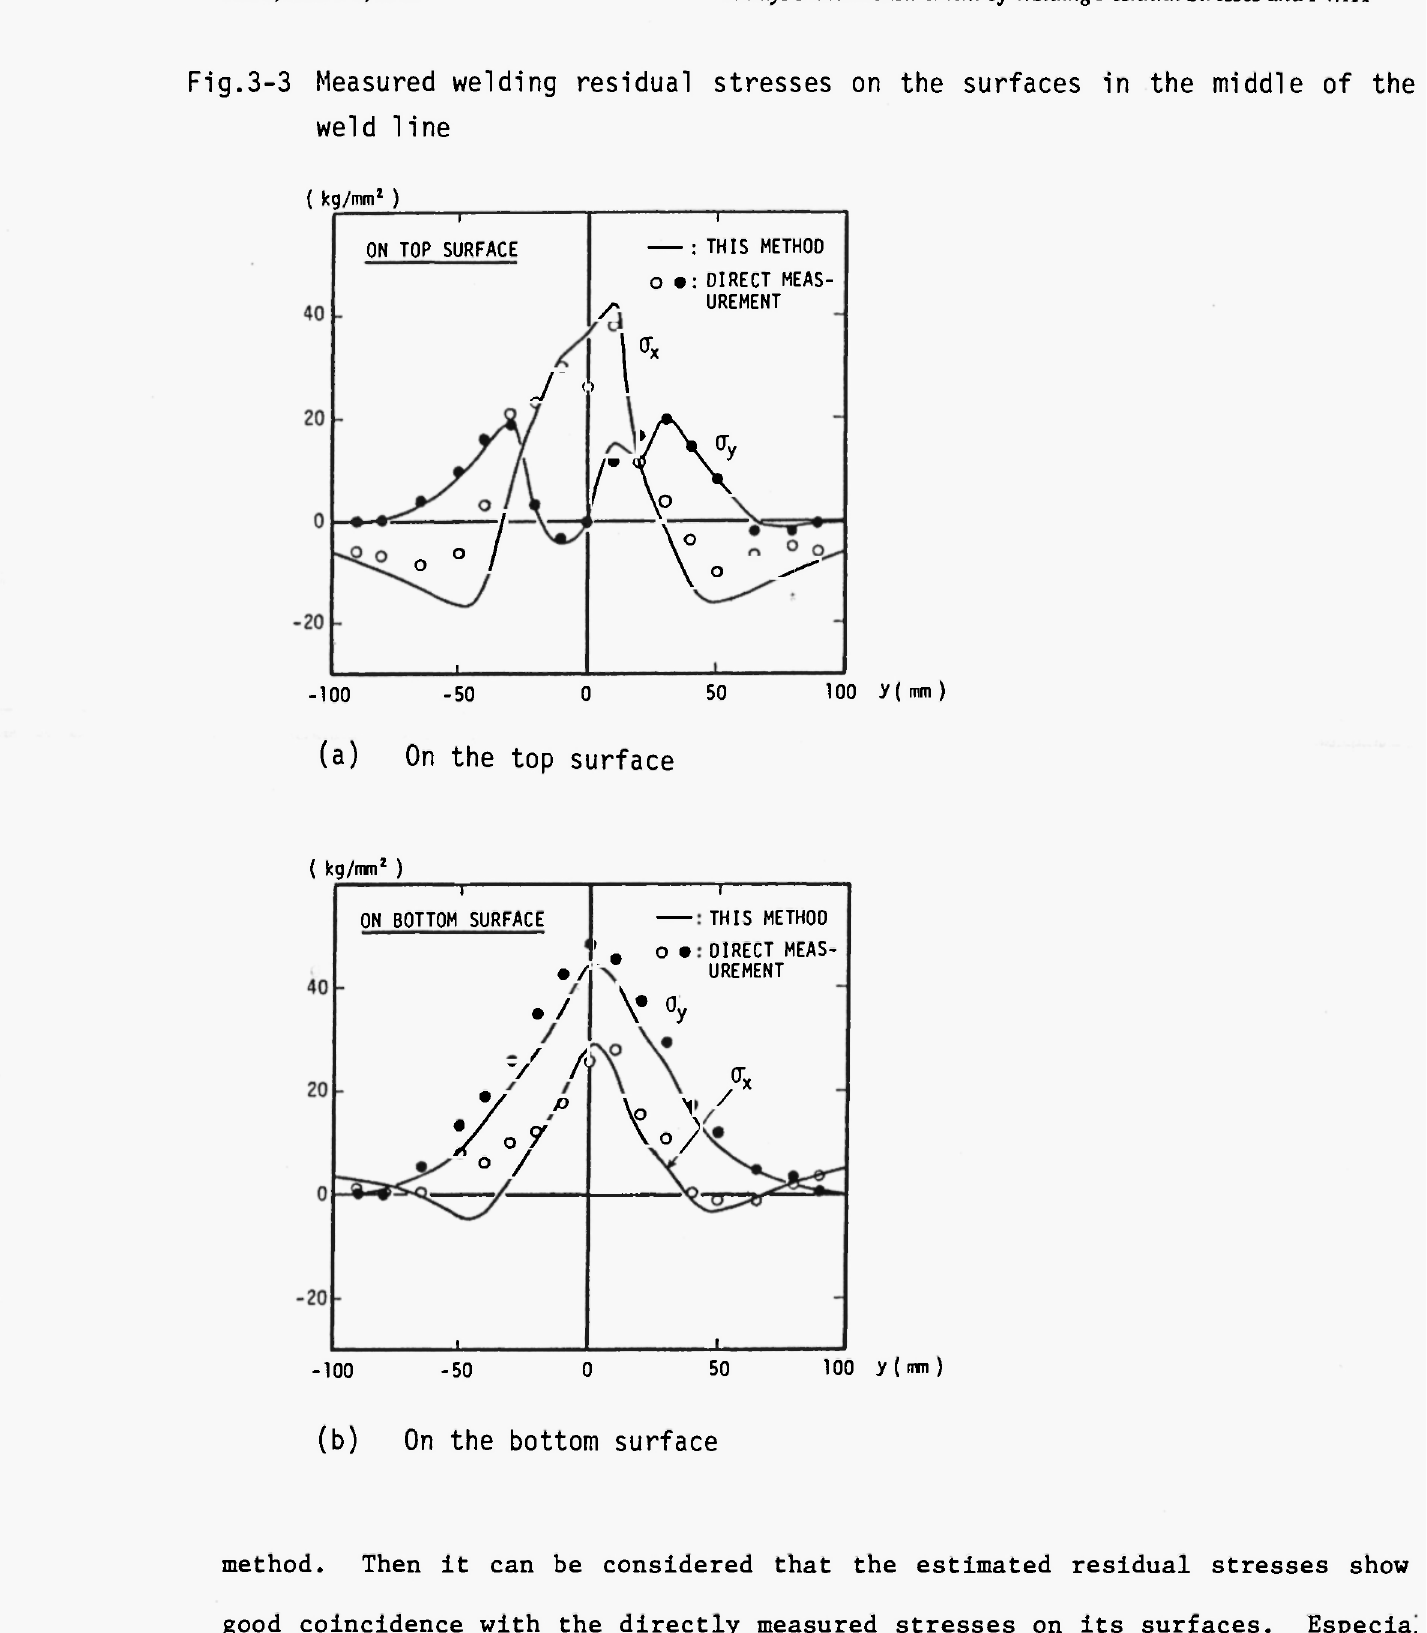
Fig.3-3 Measured welding residual stresses on the surfaces in the middle of the weld